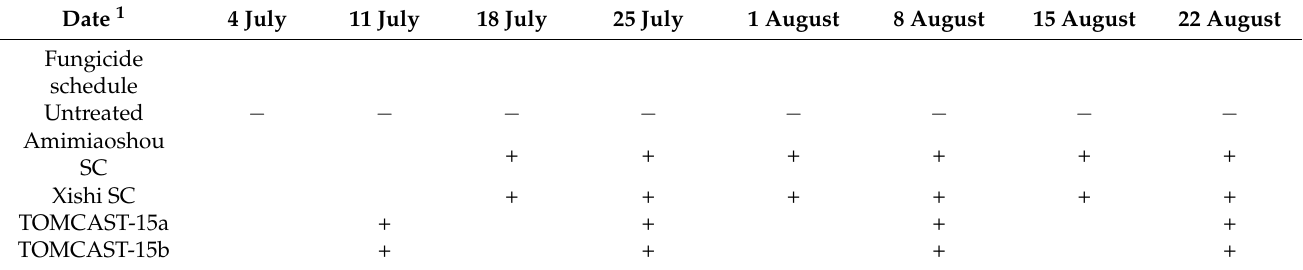
Table 1. Dates of spraying fungicide to control potato early blight during the experiment in 2020.